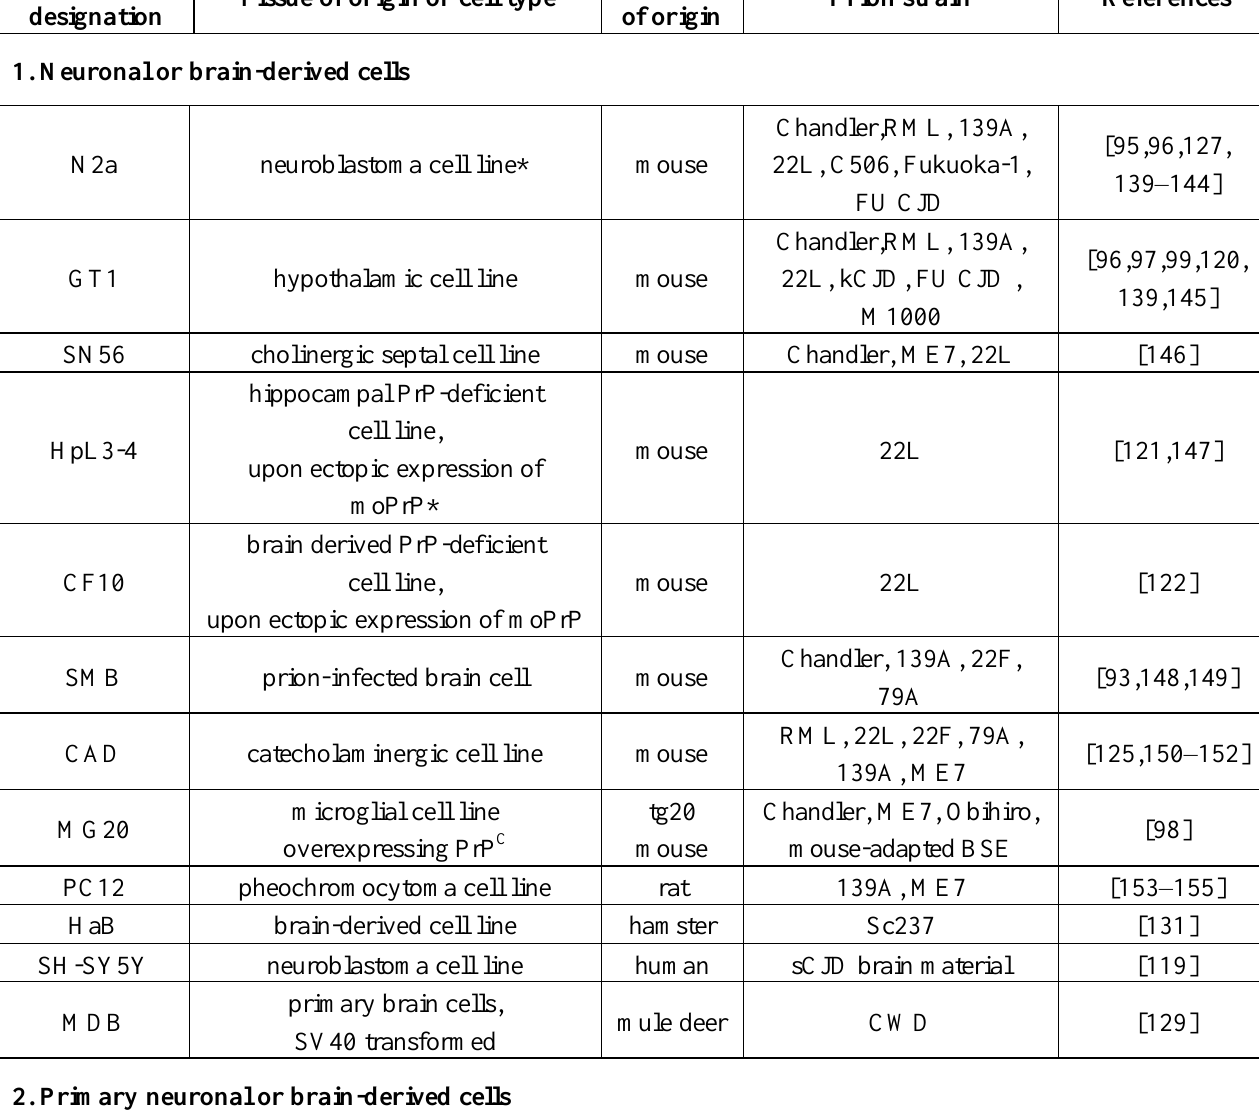
Table 1. Cell culture models susceptible to transmissible spongiform encephalopathy (TSE)